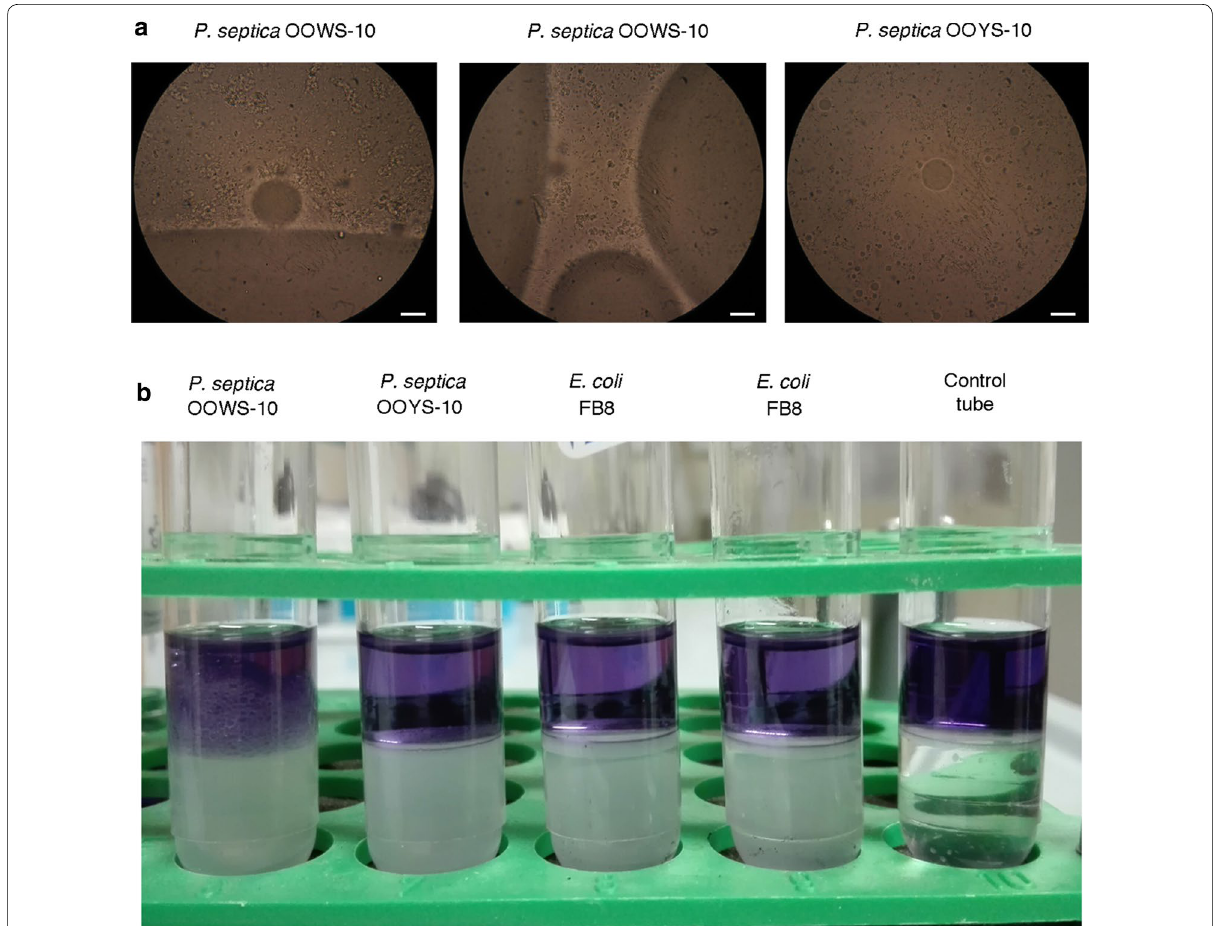
Fig. 6 Emulsification activity associated with P. septica isolates OOWS-10. a Behaviors of P. septica OOWS-10 and OOYS-10 in an olive oil–water mixture. Note the tendency of P. septica OOWS-10 to form clusters at the interface of the oil–water mixture. The white bars represent 10 μm. b Emulsification activity assay. P. septica OOWS-10 and OOYS-10 were grown to confluence on LB agar, harvested and resuspended in PBS. Bacteria were removed by centrifugation and equal volume of bacteria supernatants and diesel fuel containing the lipophilic dye Sudan Black were then mixed, and allowed to separate in a test tube. E. coli strain FB8 was used as a negative